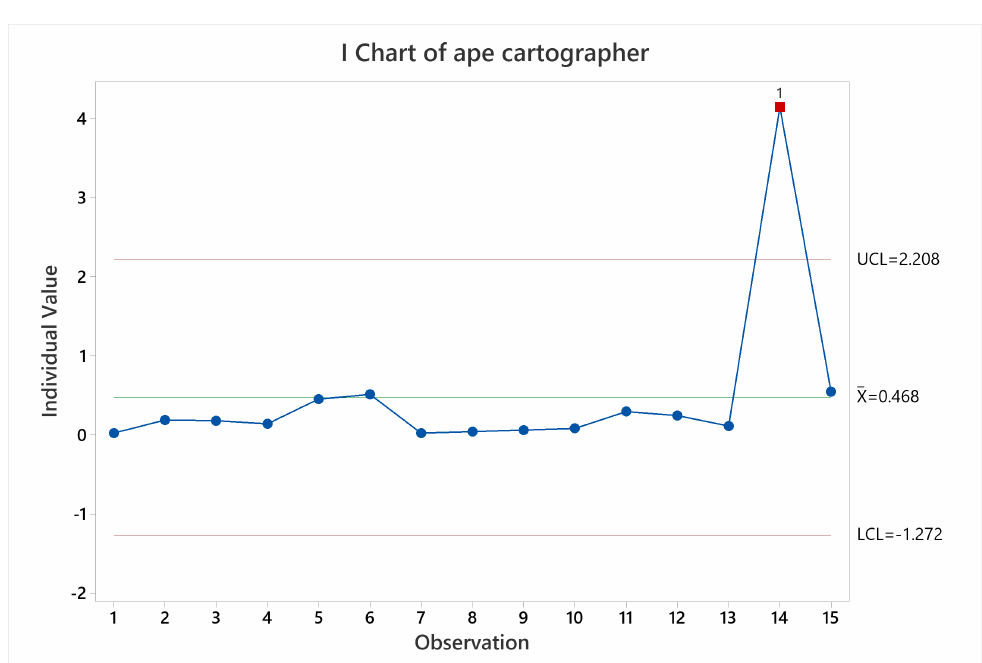
Figure 11. Pose accuracy mean behavior for